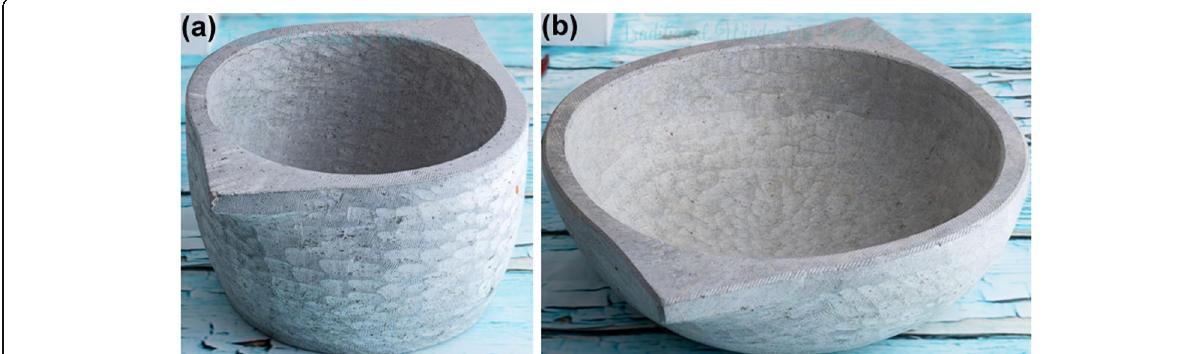
Fig. 1 The soapstone made a storage container and b bowl shaped pan/